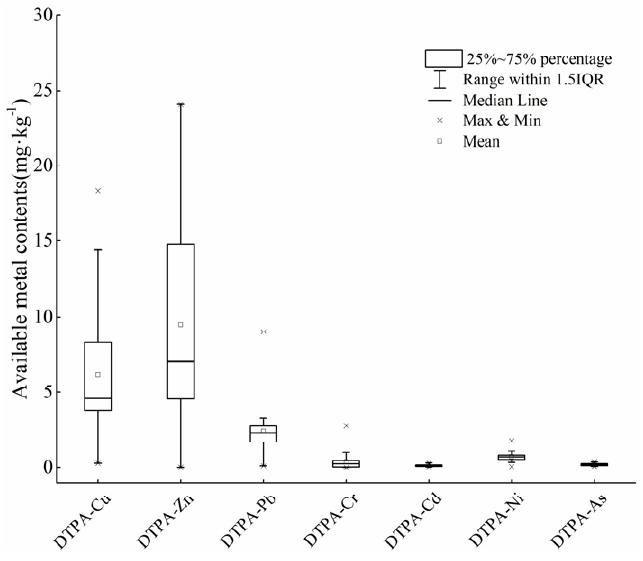
Figure 3. DTPA-extractable metals content (mg·kg --1 ) in soil.